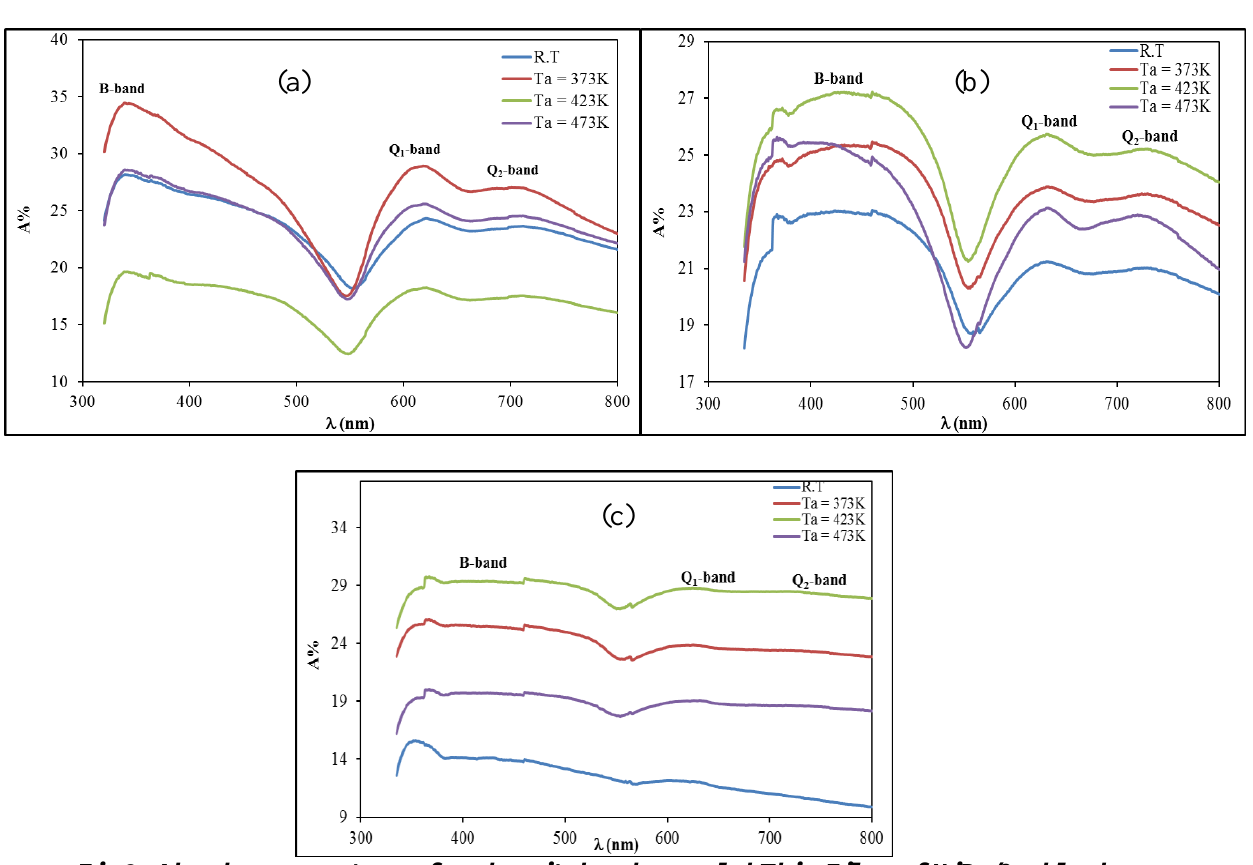
Fig.2: Absorbance spectrum of as-deposited and annealed Thin Films of NiPc/C with three different ratios of C